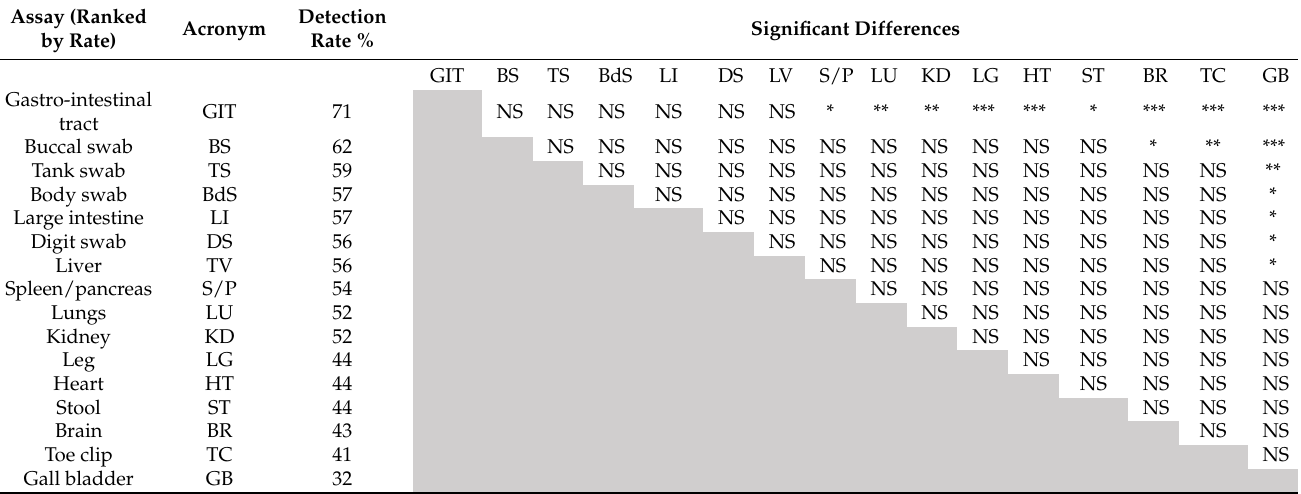
Table 3. Sample types ranked by detection rate (%) with significant differences of pairwise compar- isons between sample types illustrated.